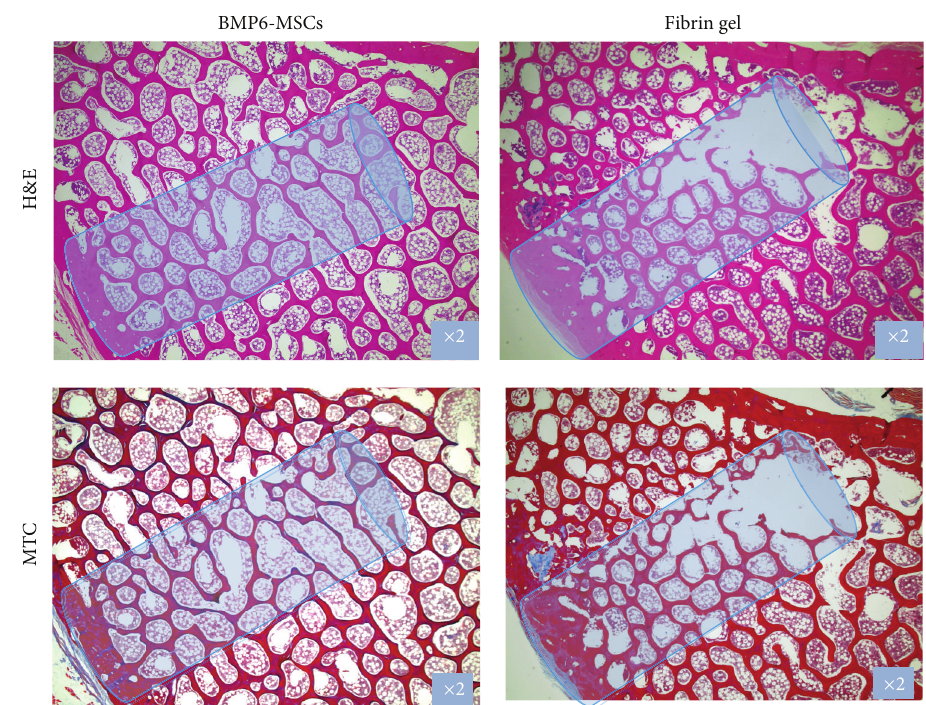
Figure 5: Histological sections of vertebral bone defects. Treated vertebrae were harvested and processed for histology. Sections were stained with H&E and Masson’s Trichrome and imaged using a light microscope; representative images showing advanced defect closure in the BMP6-MSC group versus the control (fibrin gel only)